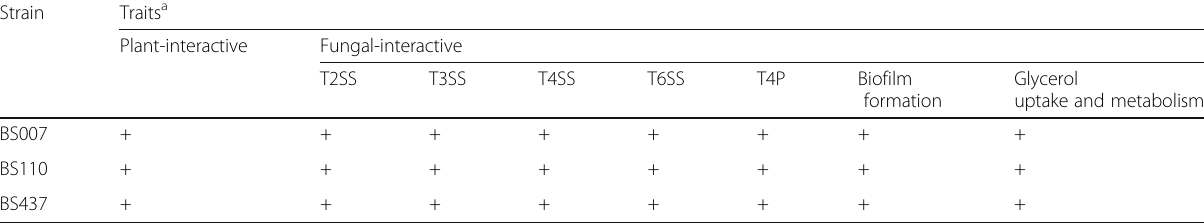
Table 7 Presumed plant- and fungal-interactive traits in Paraburkholderia terrae strain BS110, BS007, and BS437 Strain Traits a